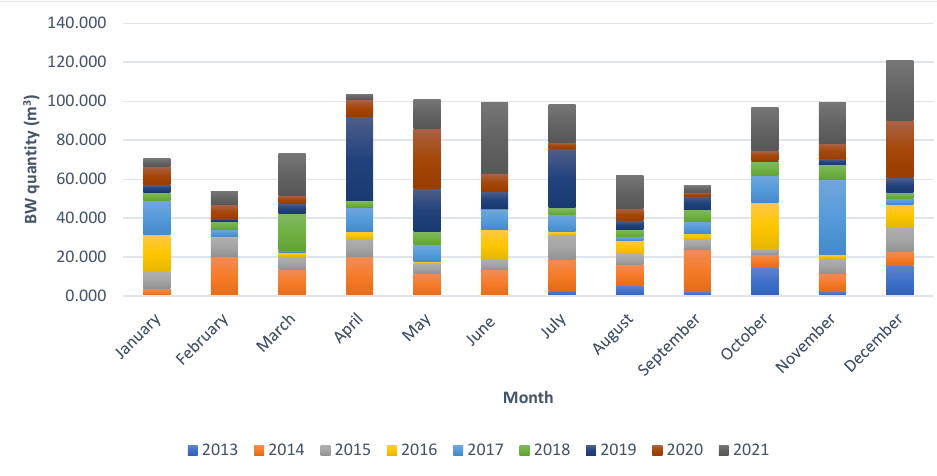
Figure A3. Annual BW quantities discharged by ship type.